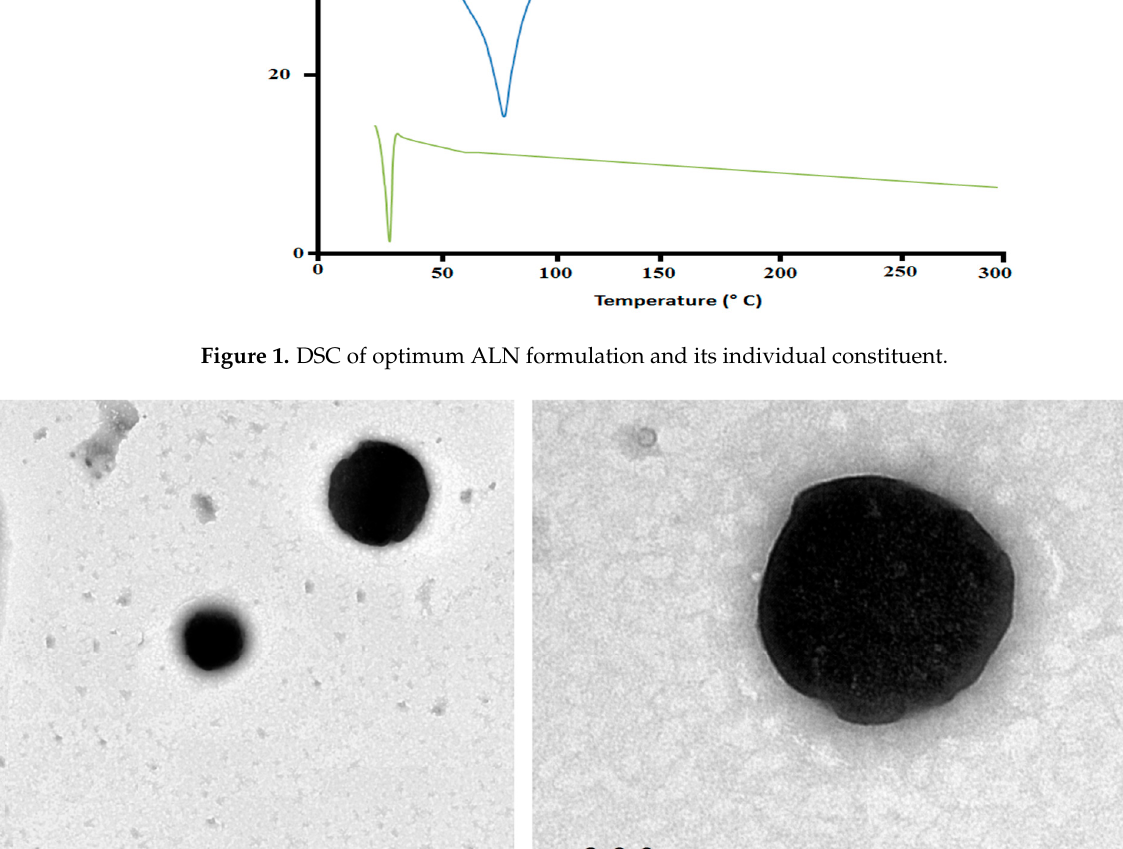
Figure 2. Transmission electron microscopy of optimum ALN formulation.